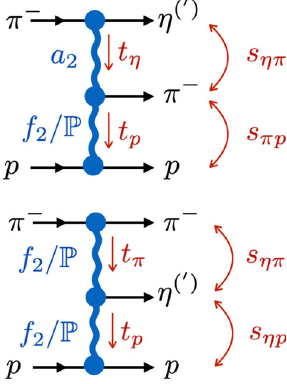
Fig. 5 Fast- η (top) and fast- π (bottom) amplitudes